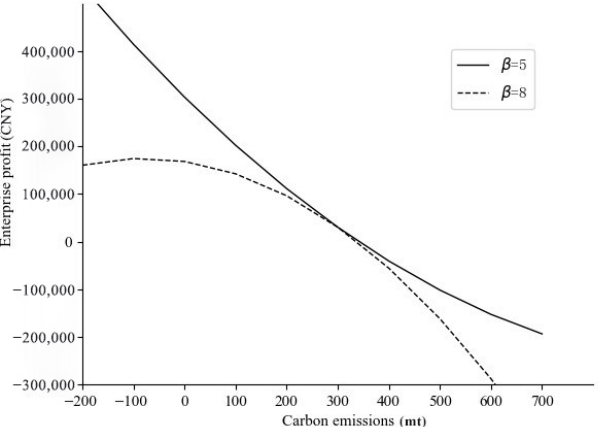
Figure 5. The impact of carbon emissions on corporate profits under different carbon emission reduction coefficients.